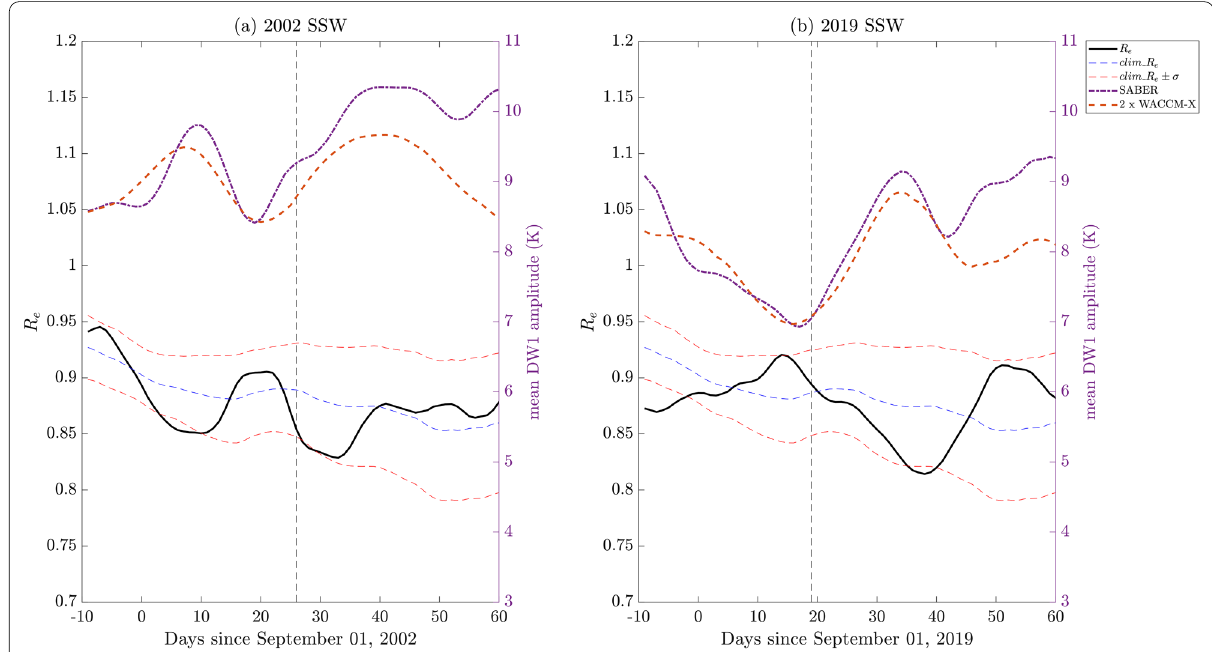
Fig. 7 Same as Fig. 6 except for (a) 2002 and (b) 2019 SH